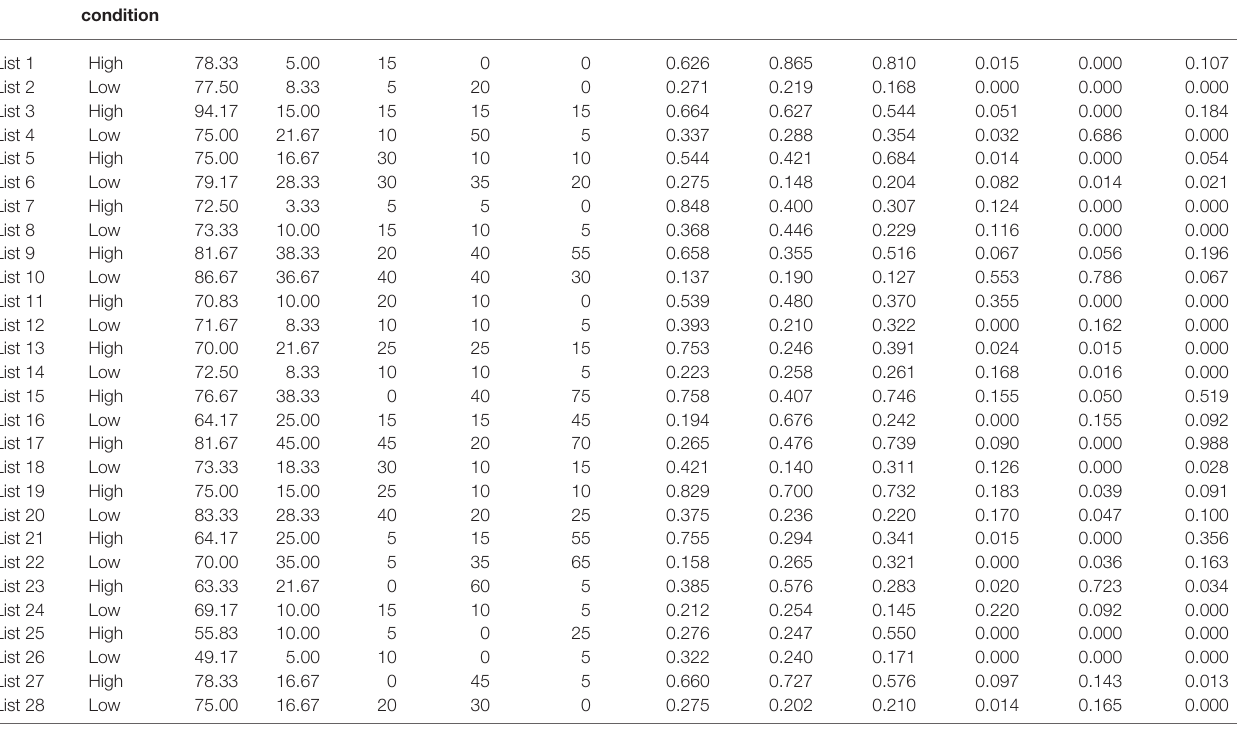
TABLE 2 | Forward associative strength (FAS) condition, mean percentages of true recognition (TR) and false recognition (FR) per list, mean percentages of false recognition per critical lure, and FAS and BAS values per critical lure were included. List FAS TR list condition